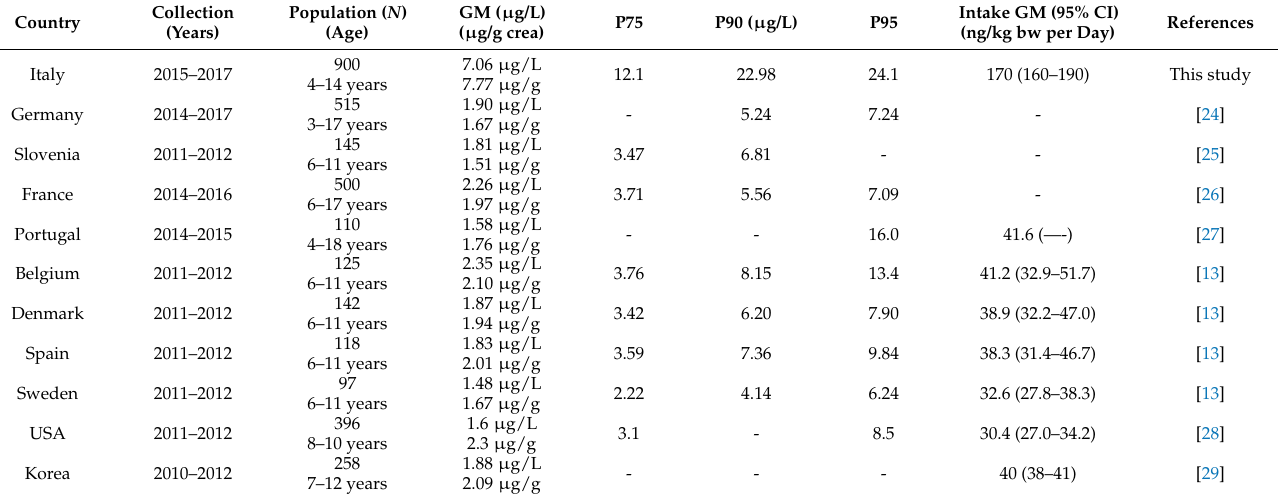
Table 6. Overview of biomonitoring studies on BPA urinary levels in children expressed as geometric mean (GM) of unadjusted ( µ g/L) and creatinine-adjusted ( µ g/g crea) concentrations, 75th, 90th and 95th percentiles ( µ g/L) and estimated BPA daily intake (ng/kg bw per